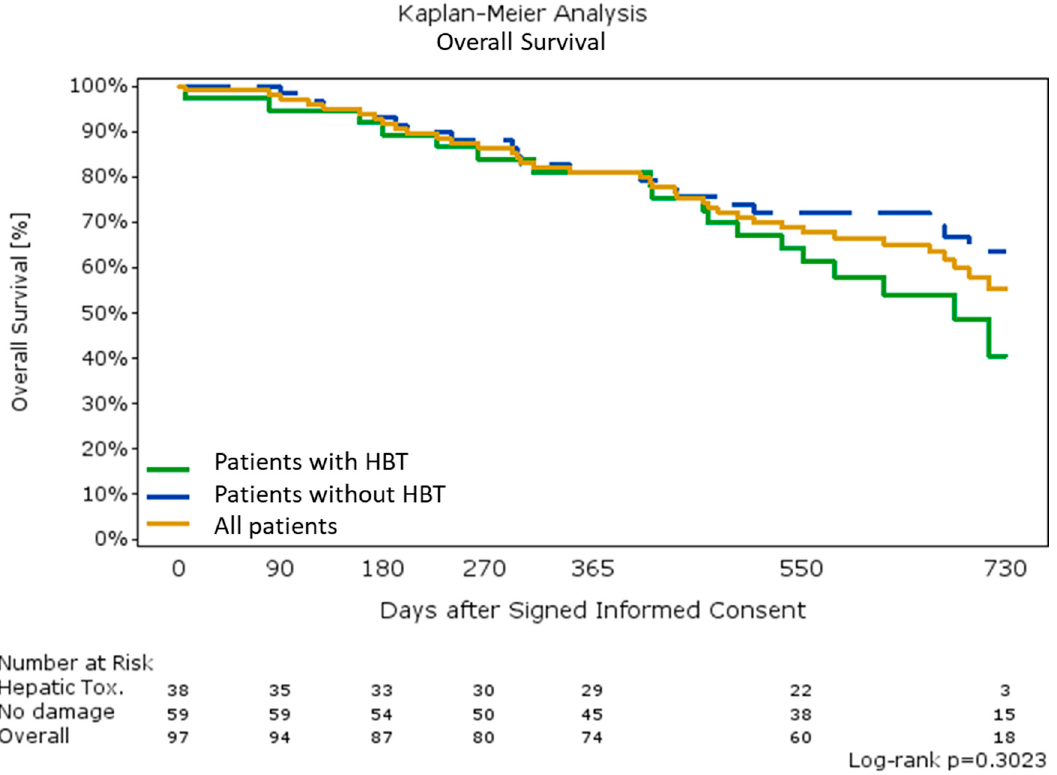
Figure 4. Overall survival (HBT = hepatobiliary toxicities).